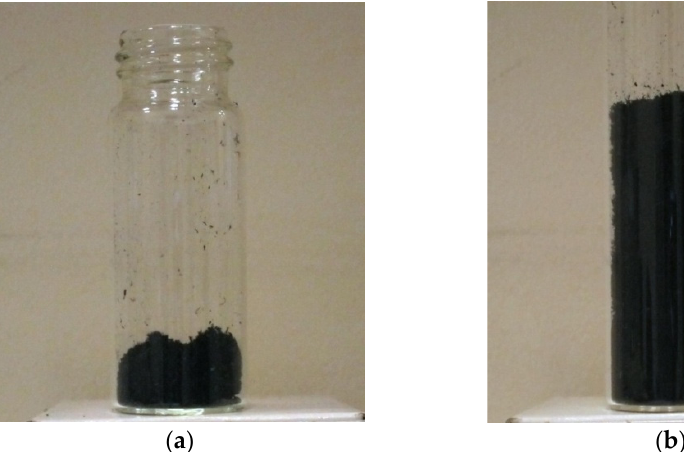
Figure 6. 0.1 g of CNTs before ( a ) and after ( b ) RESS.